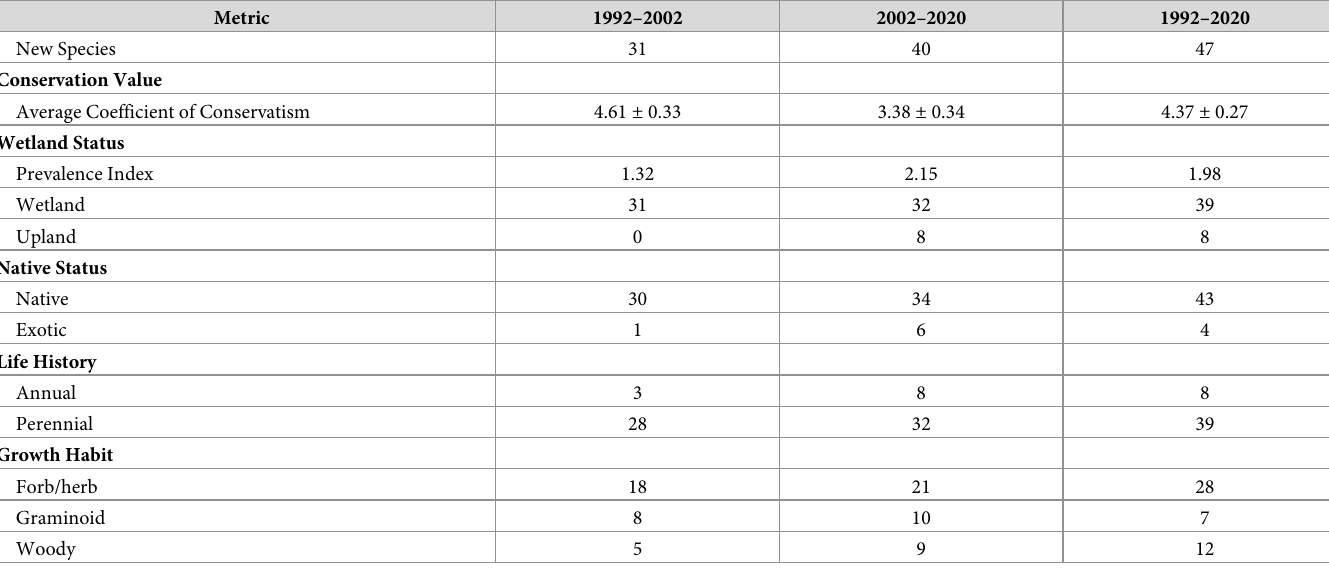
Table 2. Descriptions of the species gained between floral surveys of Quarry